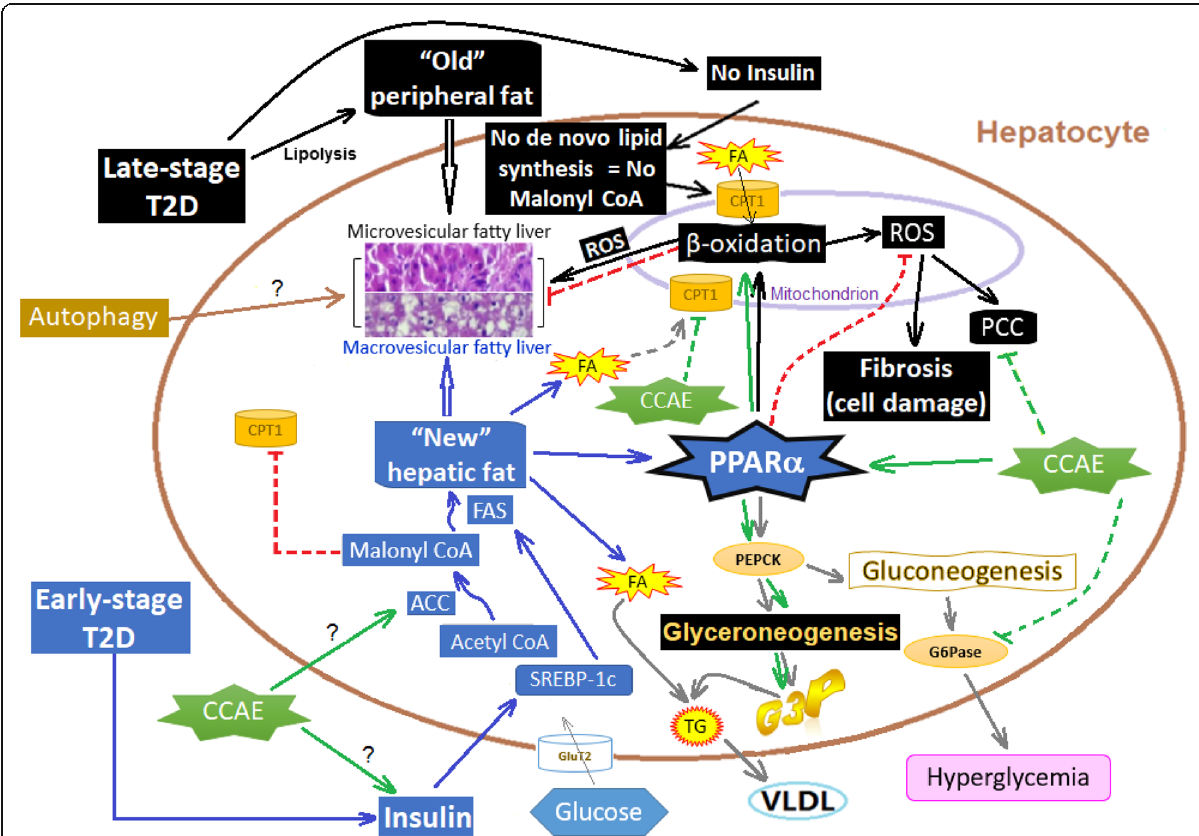
Fig. 8 The effect of CCAE on the course of events in ET2D (blue boxes) and LT2D (black boxes). Low FA β -oxidation/disposal may give rise to the fatty liver when accompanied by increased DNL, as it may occur in ET2D. Enhanced β -oxidation of FAs is expected to prevent fatty liver unless the rate of FA entry into the liver overwhelms the capacity of the mitochondria, as it may occur in LT2D, when it may lead to mitochondrial dysfunction and enhanced ROS production. Meanwhile, the attenuation of free radical scavenging mechanisms would lead to fatty liver, oxidative stress, fibrosis, and liver damage. CCAE was able to fight against hyperglycemia and fatty liver in many frontlines, including free radical scavenging and lowering ROS levels, inhibiting CPT1, activating the expression of PPAR α , and directing PEPCK activity more towards glyceroneogenesis than towards gluconeogenesis. Another vital function of PEPCK, not shown here, is to carry out cataplerosis, the removal of citric acid cycle intermediates to prevent their accumulation in the mitochondrial matrix [66,